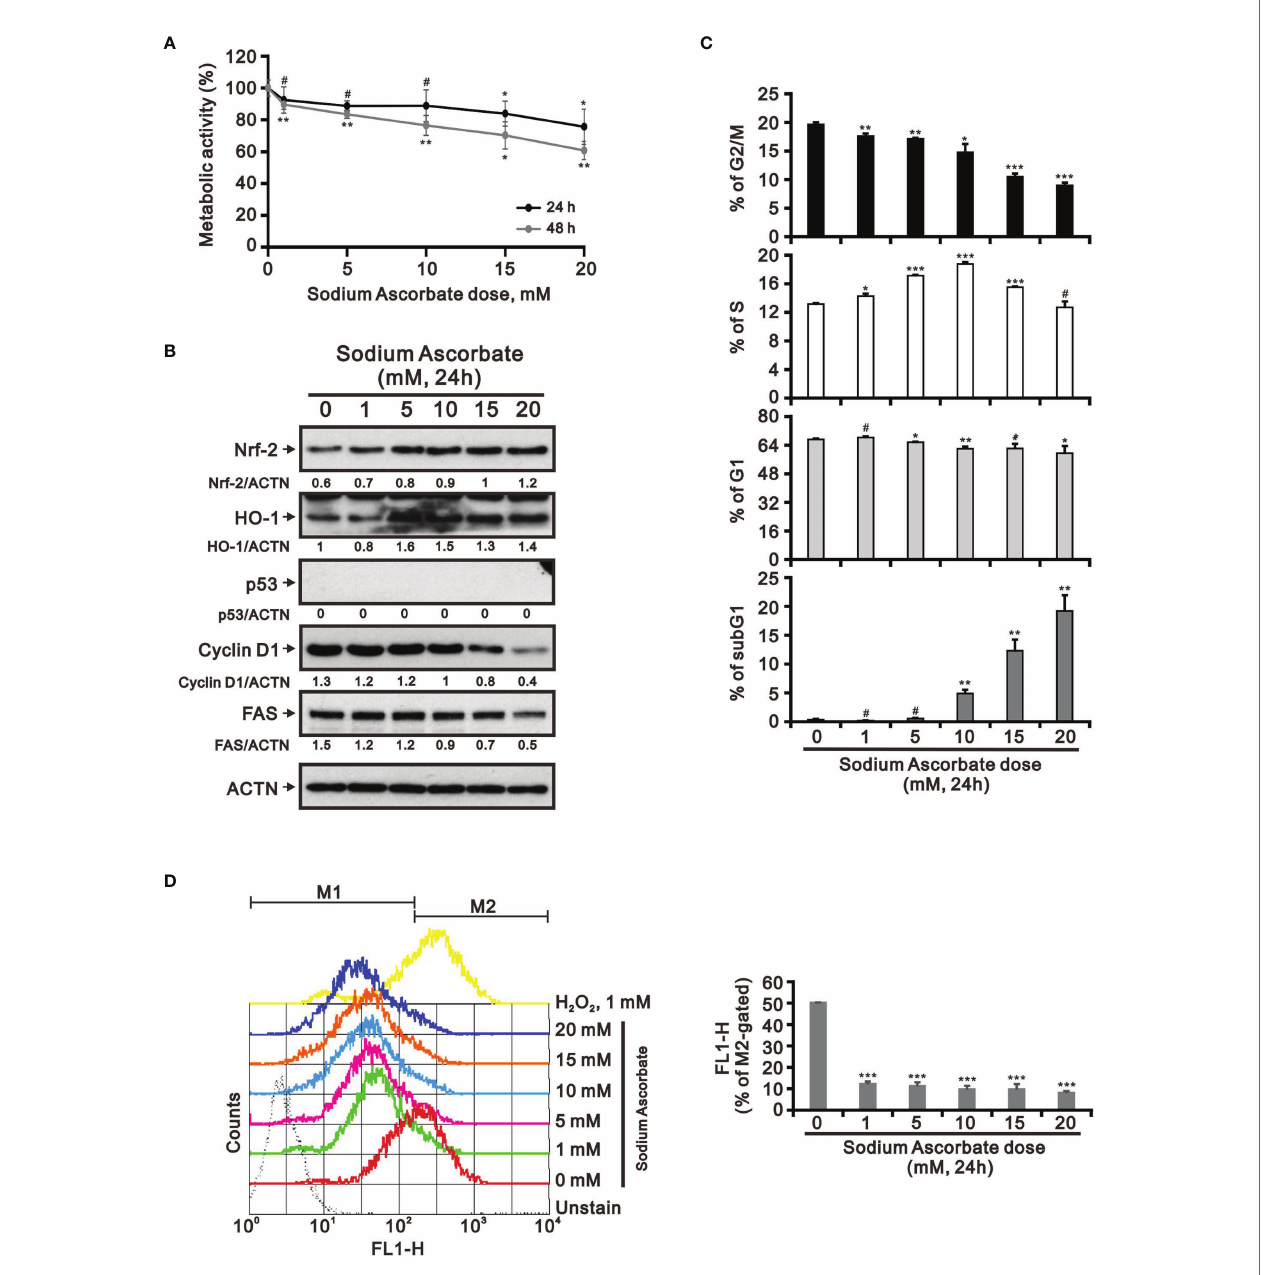
FIGURE 6 | Effects of sodium ascorbate on cell metabolic activity in Hep3B cells. (A) Hep3B cells were treated for 24 h or 48 h with the indicated concentrations of sodium ascorbate. Cell metabolic activity was measured using the MTT assay. Hep3B cells were treated with the indicated concentrations of sodium ascorbate for 24 h, after which their cell lysates were subjected to (B) Western blot analysis using antibodies against the indicated proteins (ACTN was the protein loading control), (C) cell-cycle pro fi ling using fl ow cytometry analysis, and (D) ROS status determination using 10 m M DCFH-DA. The cell volume gating strategy involved FSC-H and SSC-H, and the median fl uorescence intensity of the vehicle was used as the starting point for M2 gating. Protein bands were quanti fi ed through pixel density scanning and evaluated using ImageJ, version 1.44a (http://imagej.nih.gov/ij/). We show one representative result. Bars depict the mean ± SD of three independent experiments. # p > 0.05, * p < 0.05, ** p < 0.01, and *** p < 0.001 compared with the vehicle (Student ’ s